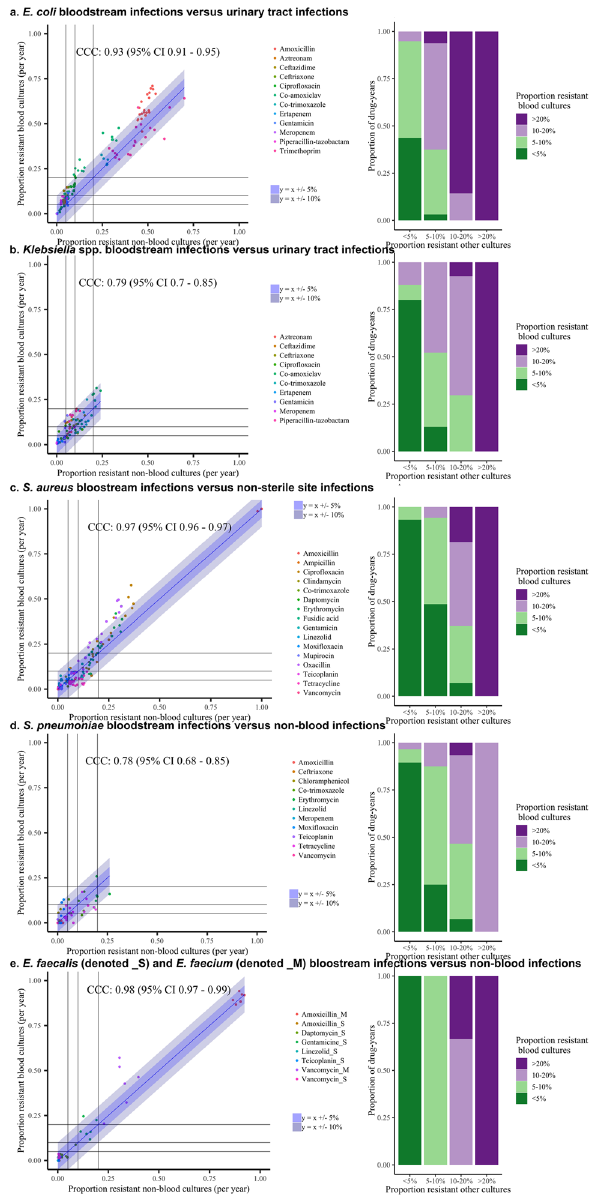
Figure 2. Association between resistance prevalence in blood versus non-blood cultures for ( a ) E. coli , ( b ) Klebsiella spp., ( c ) S. aureus , ( d ) S. pneumoniae , ( e ) E. faecalis and E. faecium , Oxfordshire 1998–2018 Left: Scatterplot of the proportion of resistant non-blood cultures versus the proportion of resistant blood cultures per year for all antibiotics. Each dot reflects resistance prevalence for one antibiotic in one specific year, coloured by antibiotic type. Line of identity shown in blue, with associated ± 5% and ± 10% agreement discordance intervals. Additional lines are drawn to denote 0.05 (5%), 0.1 (10%) and 0.2 (20%) resistance prevalence thresholds for blood (horizontal lines) versus non-blood (vertical lines) cultures for ease of visualisation of agreement between clinically meaningful resistance categories in these two types of samples. Right: Stacked bars representing the data in the left-hand panel grouped as categorical resistance prevalence ranges, classifying resistance prevalence in blood cultures by the proportion in urine/non-sterile site (i.e. non-blood)